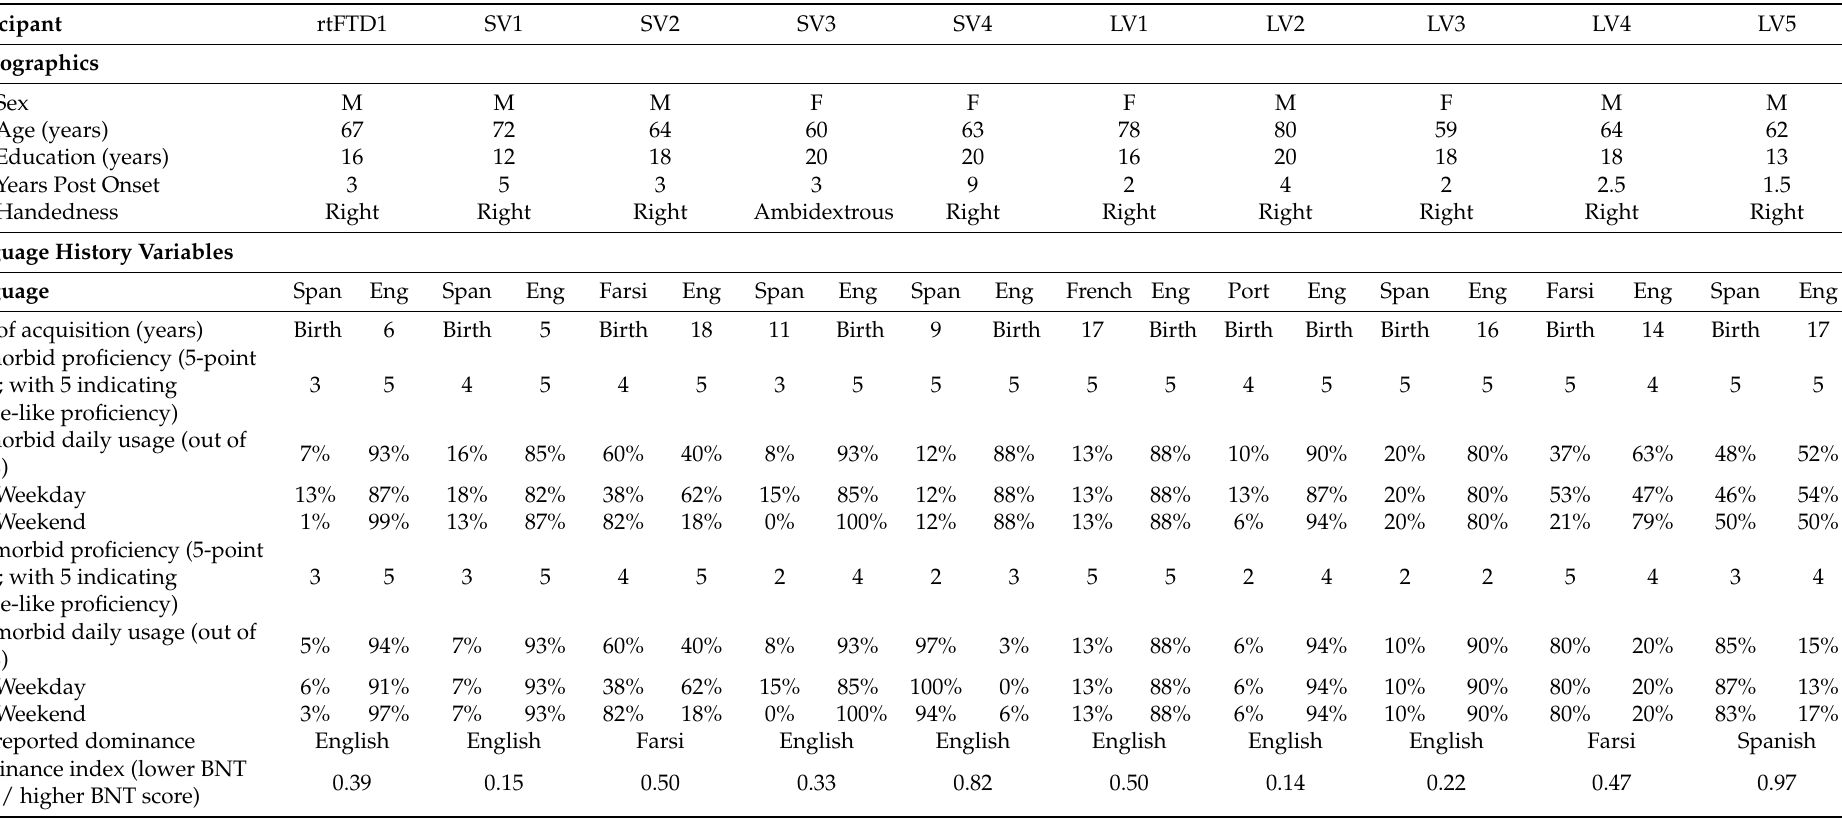
Table 1. Individual Demographic and Language History